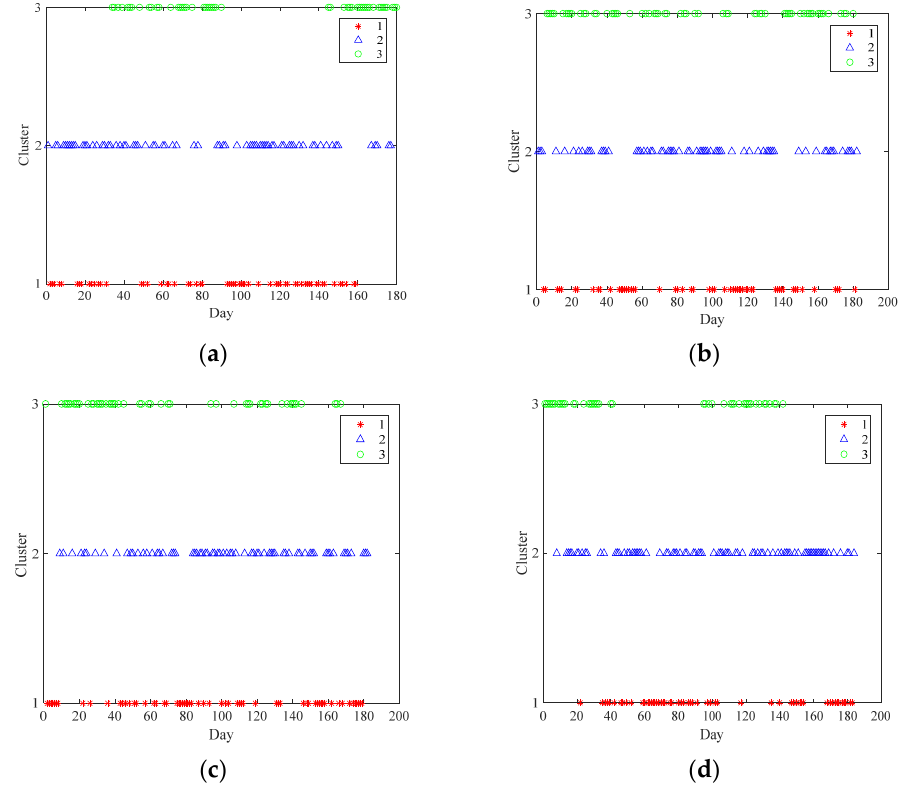
Figure 11. Cluster results of solar radiation in four seasons. ( a ) Spring; ( b ) Summer; ( c ) Autumn; ( d ) Winter.